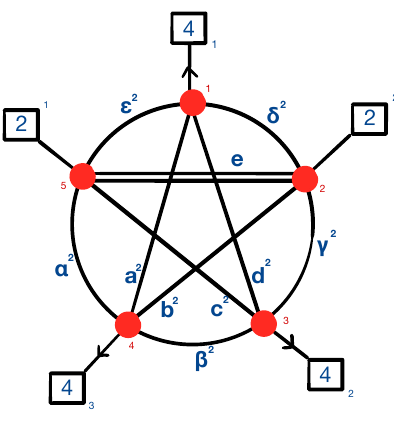
Figure 1 . The quiver dual to USp(4) g gauging (with matter) of the E 6 MN SCFT. The red dots are SU(2) gauge groups. The various letters denote fugacities for the ten abelian symmetries. The missing letters should be (cid:12)lled in by requiring the gauge symmetry to be non-anomalous. The theory has at the free point three SU(4) symmetries and three SU(2) symmetries. One of the three SU(2) symmetries rotates the two bi-fundamental (cid:12)elds between gauge nodes 2 and 5. One needs to turn on the most general cubic gauge invariant superpotential. The theory is conformal as each SU(2) gauge group has six